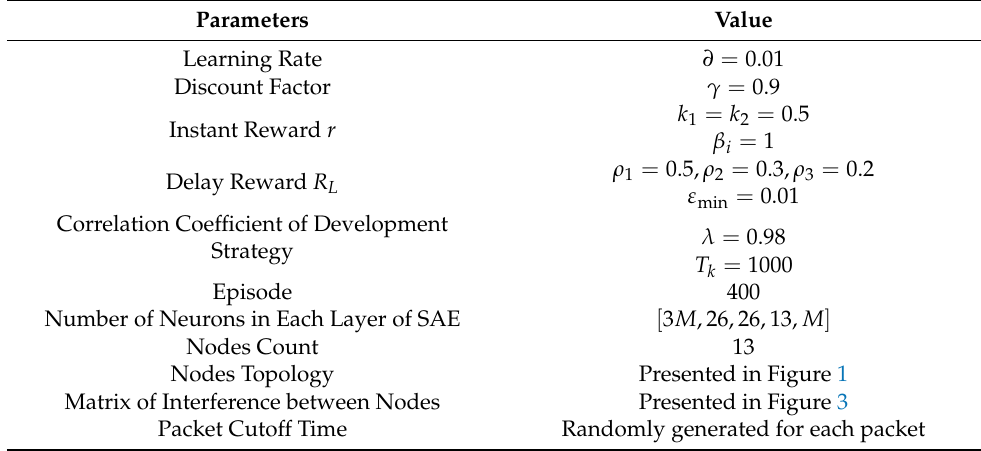
Table 2. Simulation parameters.